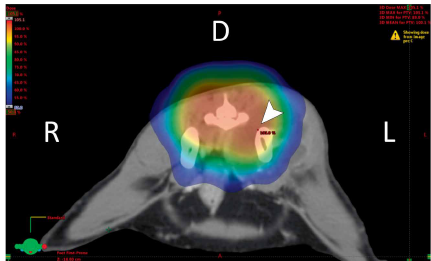
Figure 2: Color wash of radiation dose distributions for treatment of a spindle cell tumour of the spinal cord of the cat using intensity modulated and image guided technic (IMRT/IGRT). Dose color wash is superimposed on a standard window transverse plane post-contrast CT image at the level of the iliac body taken 158 weeks after the last dose of radiation. The high dose is seen in red and low dose in blue. Note the presence of the left ilium and mass within the high dose irradiation field